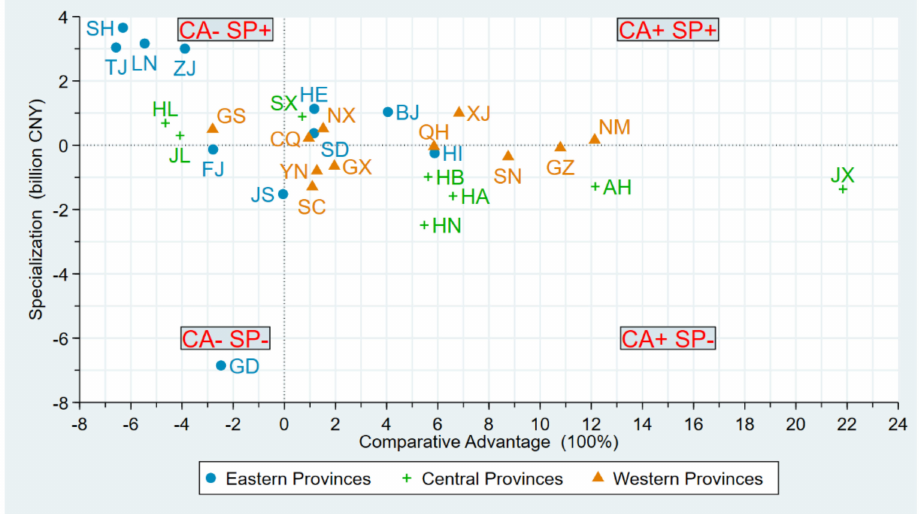
Figure 6. Provincial green investment specialization and comparative advantage in China during